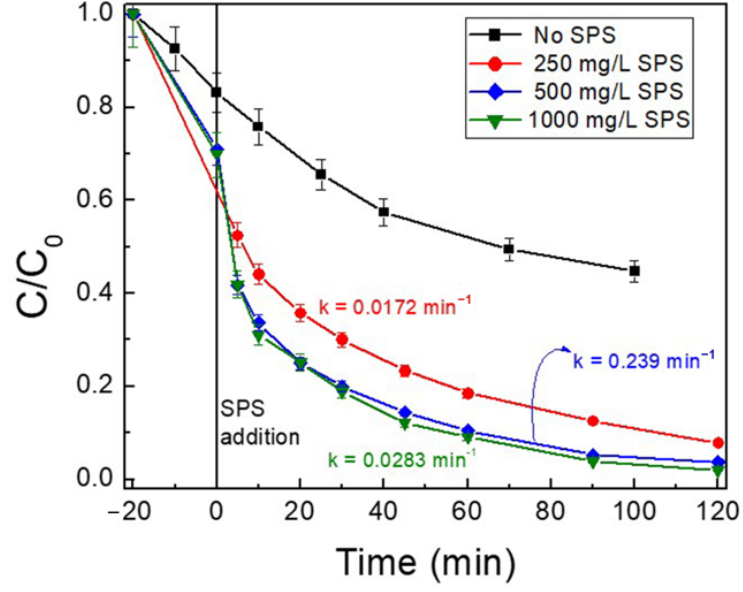
Figure 9. Effect of SPS concentration on 500 µ g/L SMX degradation with 100 mg/L biochar (RHB 850) in UPW and pH = 5.6.